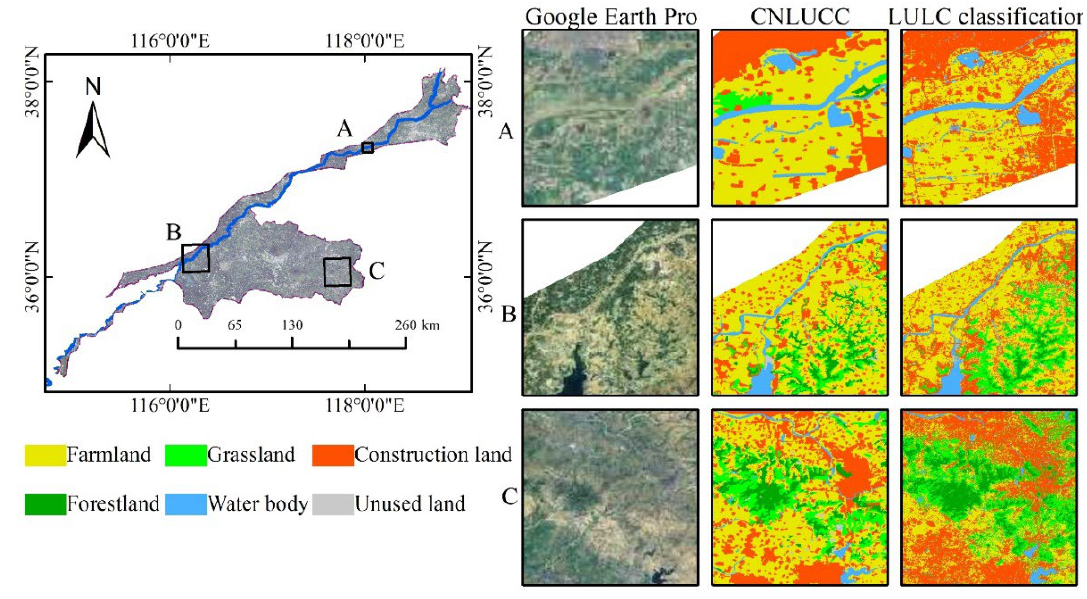
ISPRS Int. J. Geo-Inf. 2022 , 11 , x FOR PEER REVIEW